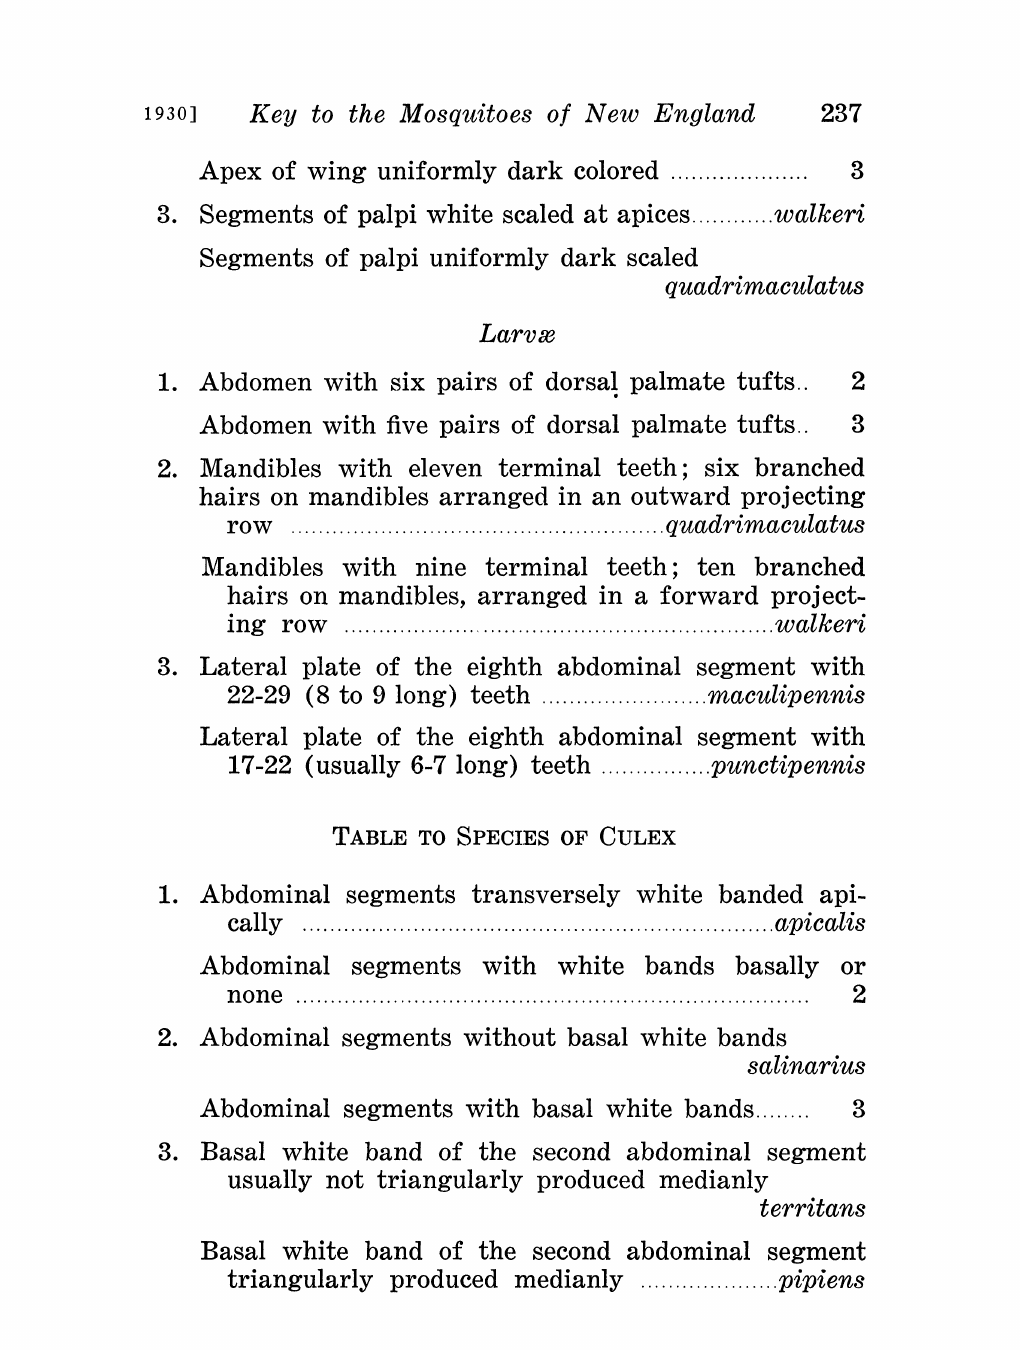
3. Basal white band of the second abdominal segment usually not triangularly produced medianly Basal white band of the second abdominal segment triangularly produced